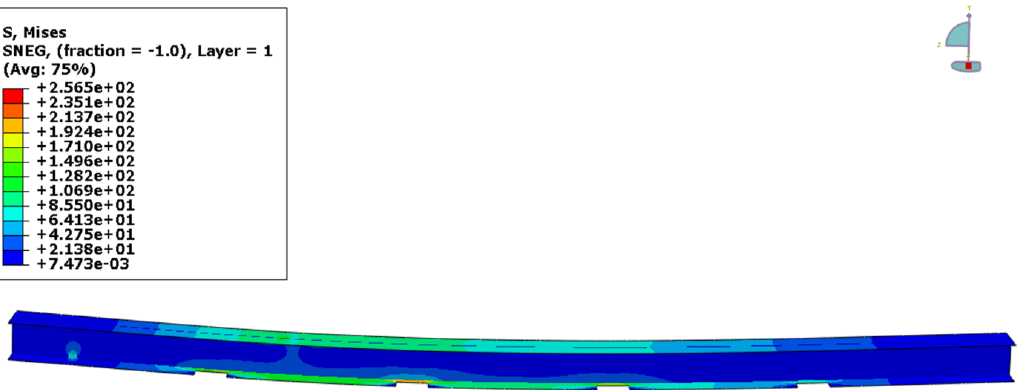
Figure 14. Failure mode of the bare GFRP pultruded profile subject to flexure from FEM (stress values are in MPa).